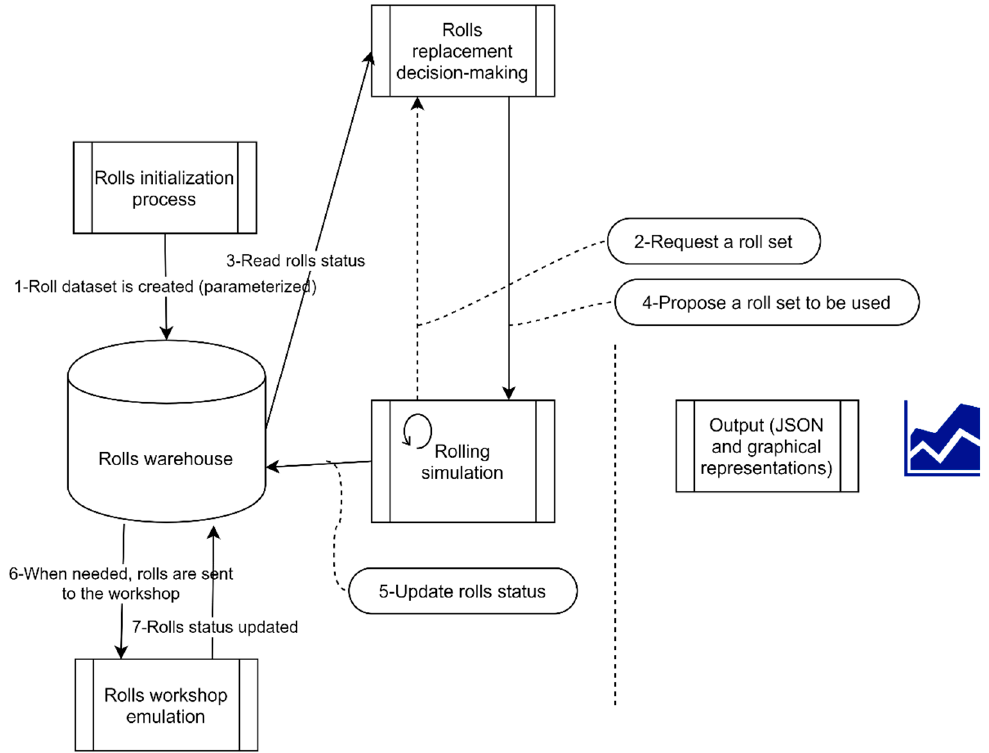
Figure 3. Simulator